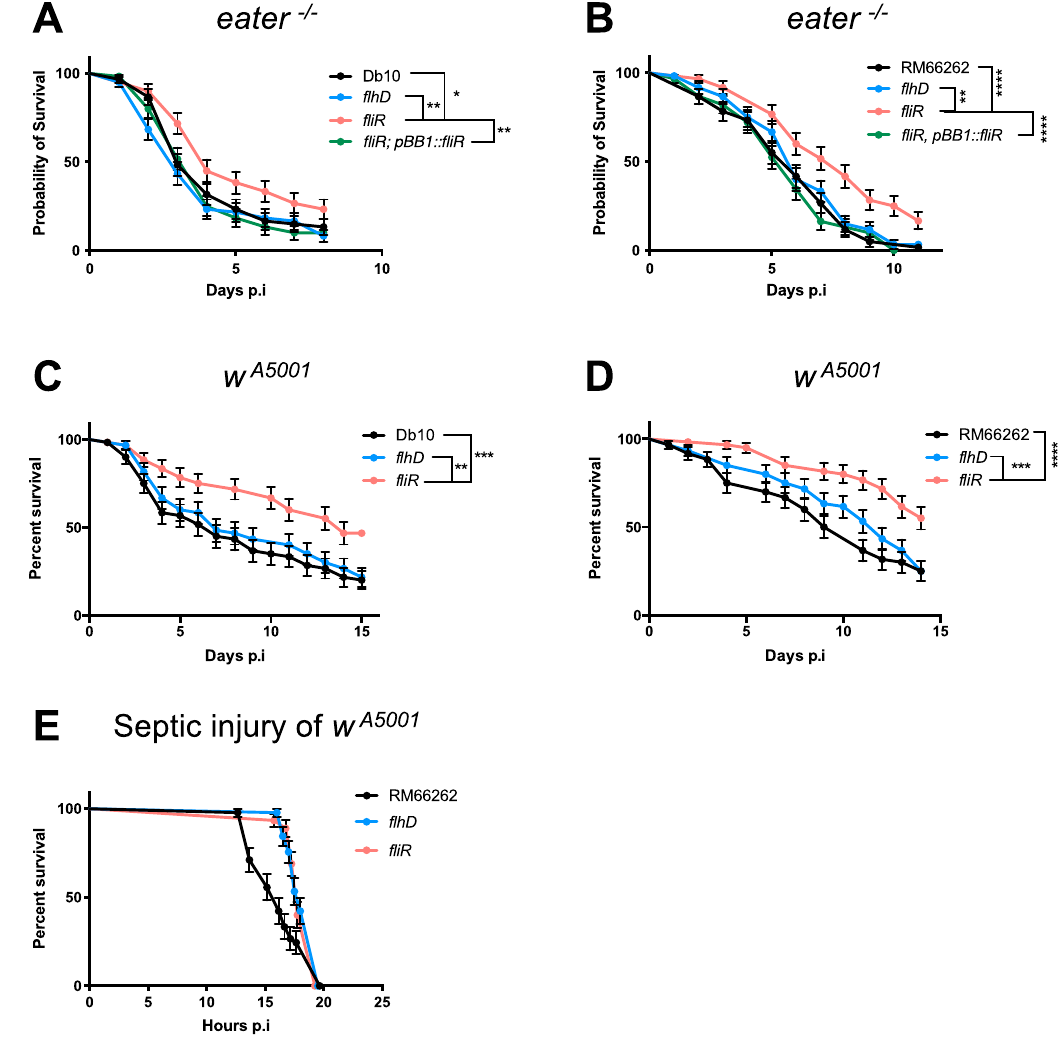
IPTG (0.5 mM) was added for the fliR rescue strain ( A – D ). ( A , B ) Survival test of eater −/− mutant flies upon oral infection by bacterial strains in either the Db10 ( A ) or the RM66262 ( B ) genetic background. ( C – D ) Survival test of w A5001 flies upon oral infection by bacterial strains in either the Db10 ( C ) or the RM66262 ( D ) genetic background. ( E ) Survival test of w A5001 after injection of bacteria at OD 600nm = 0.1. The slightly faster lethality observed after a challenge with the wild-type strain was not confirmed in subsequent experiments. Each graph represents one out of three independent experiments that yielded similar results. Error bars represent the standard error. Statistical tests were performed using